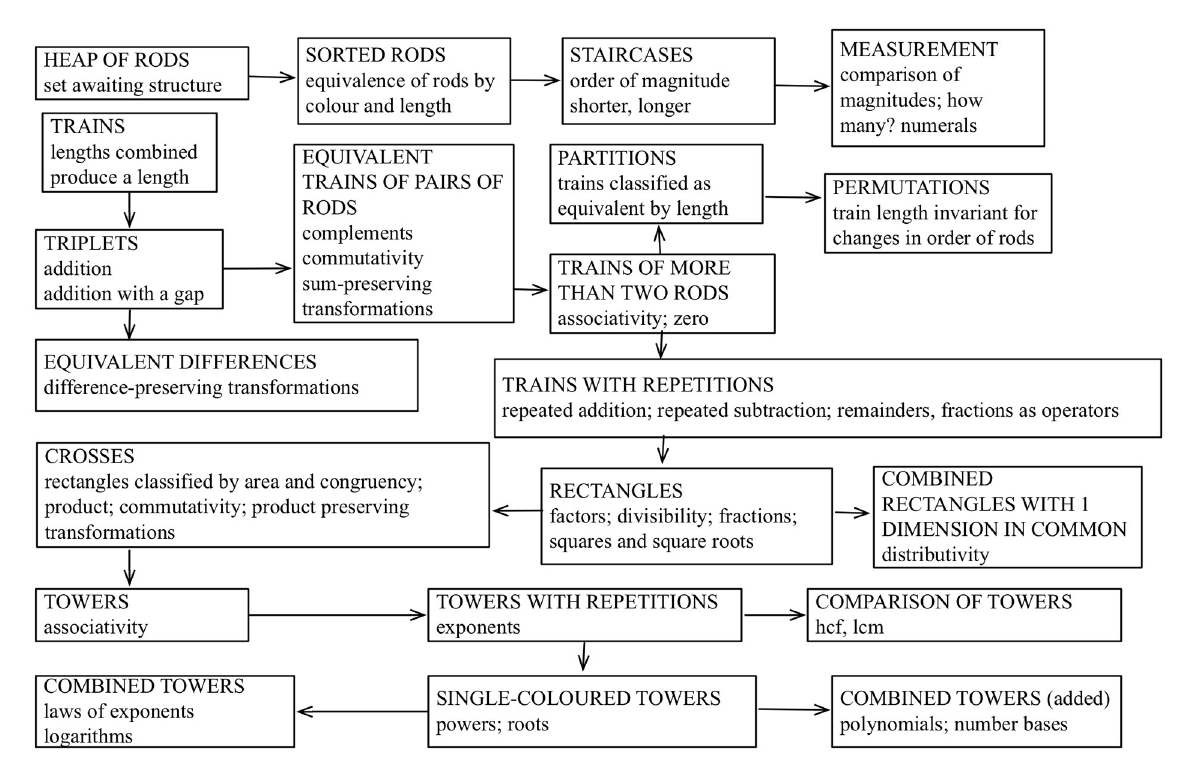
FIGURE2 A flow chart for the Cui approach to coordinating vision, audition, haptic, sensorimotor and introspective